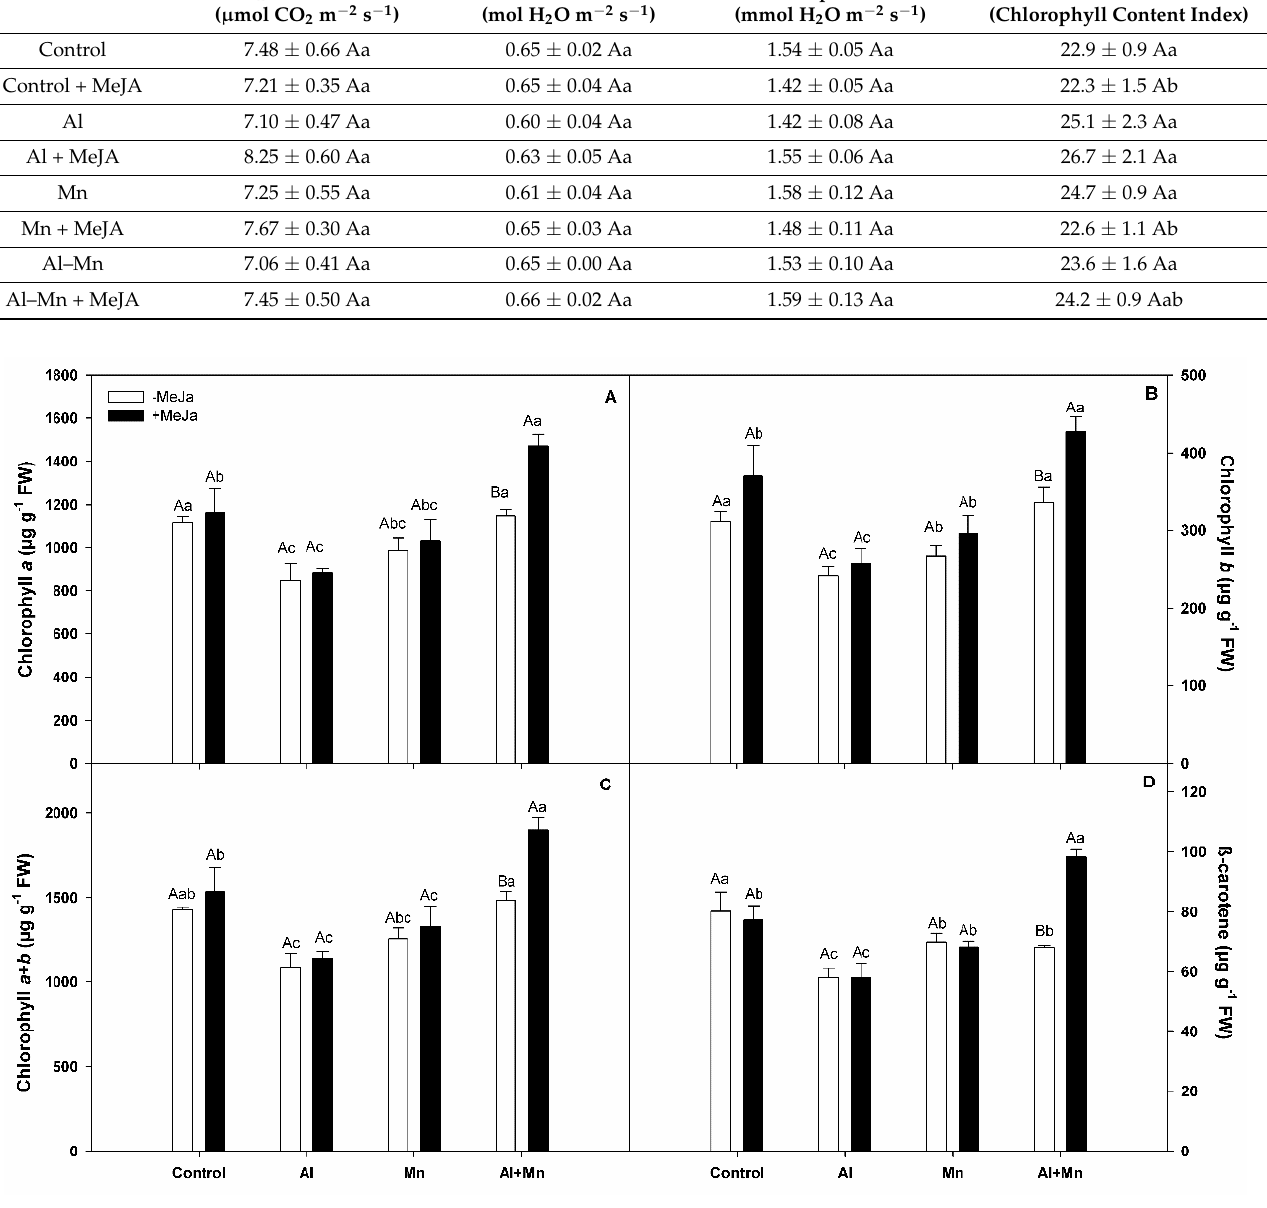
Figure 2. Chlorophylls in highbush blueberry cv. Legacy plants subjected to different soil treatments (Al, Mn, and Al–Mn toxicity), and exogenous MeJA. Chlorophylls a ( A ), b ( B ), a + b ( C ), and β -carotene ( D ). All values represent averages of ten biological replicates ± SE. Different upper-case letters indicate significant differences between MeJA treatments for the same soil conditions according to Tukey’s test ( p ≤ 0.01). Different lower-case letters indicate significant differences among soil conditions for the same MeJA treatment, according to Tukey’s test ( p ≤ 0.01).